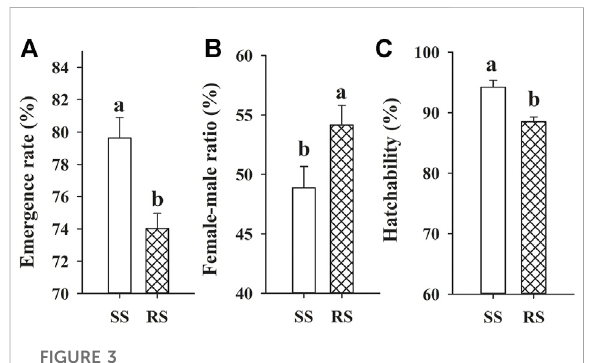
FIGURE 3 Means(±SE)ofemergencerate (A) ,female-maleratio (B) and hatchability (C) of SBPH in the SS and RS strains. Different letters above error bars are signi fi cantly different at 0.05 levels using the Tukey ’ s test.